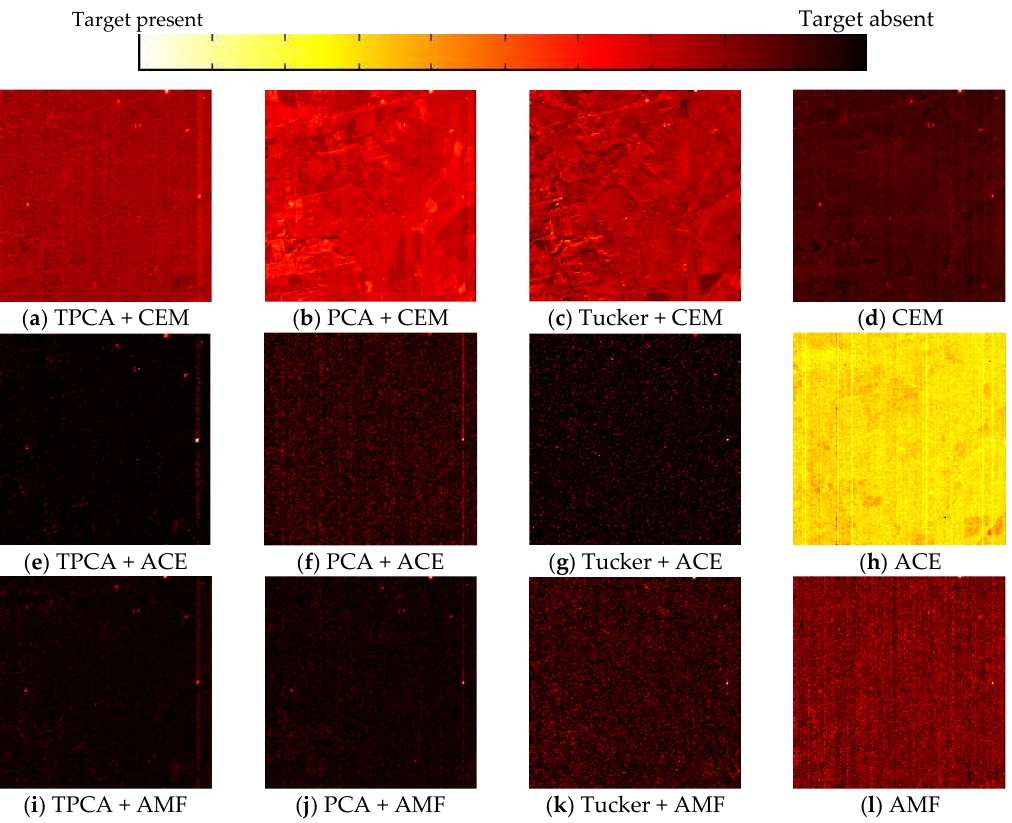
Figure 13. Detection results of the Hyperion dataset with different feature extraction methods and traditional TD methods.